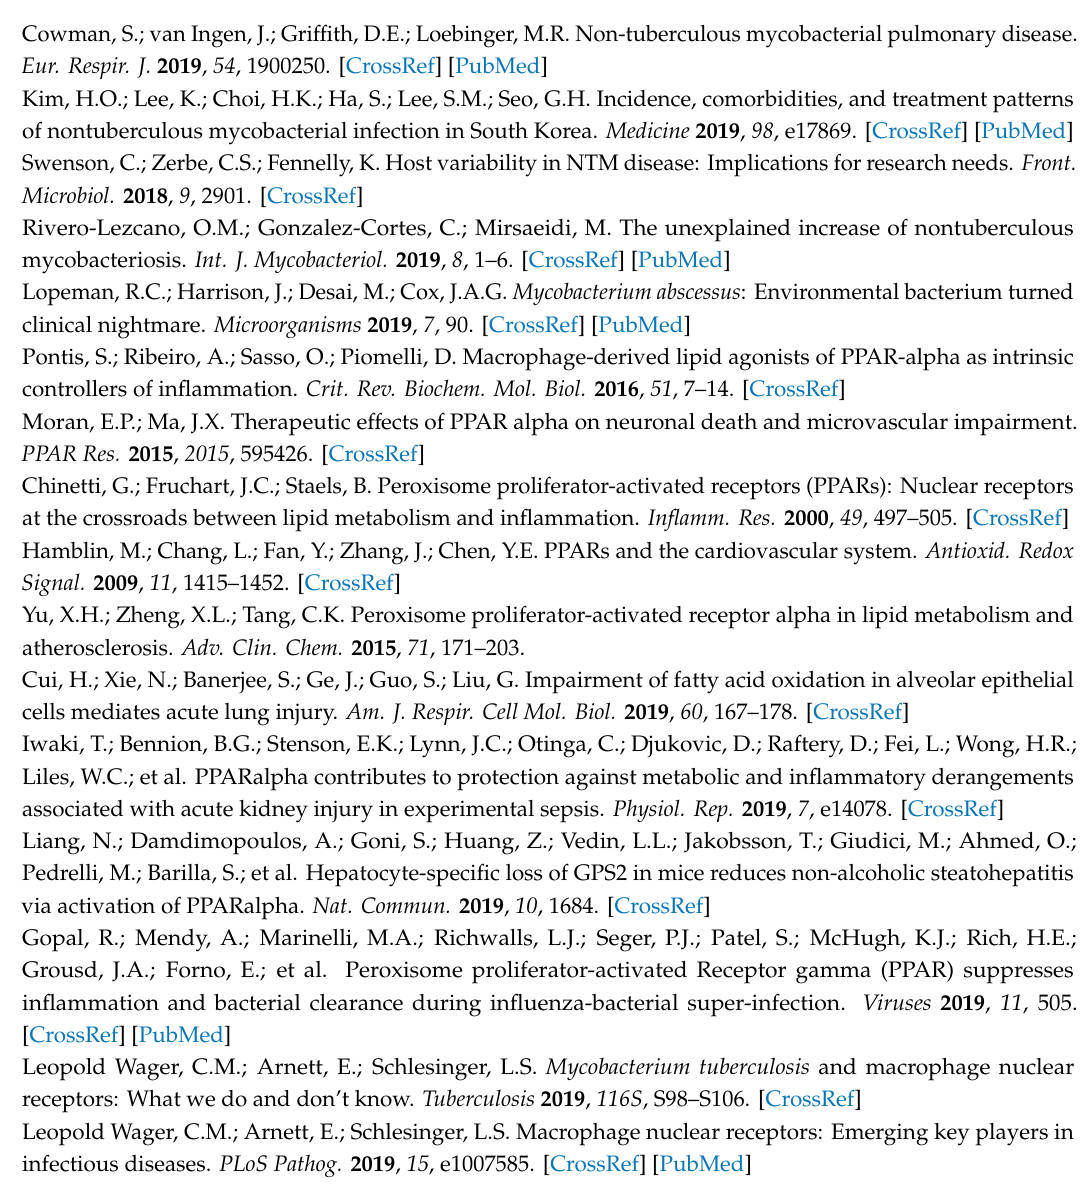
Figure S1: PPAR α suppresses activated neutrophil infiltration in Mabc-infected lung tissue, Figure S2: In vitro activity of gemfibrozil, Figure S3: Treatment of macrophages with GEM, but not GW7647, enhances nuclear translocation of TFEB during Mabc infection, Table S1: Primers used in this